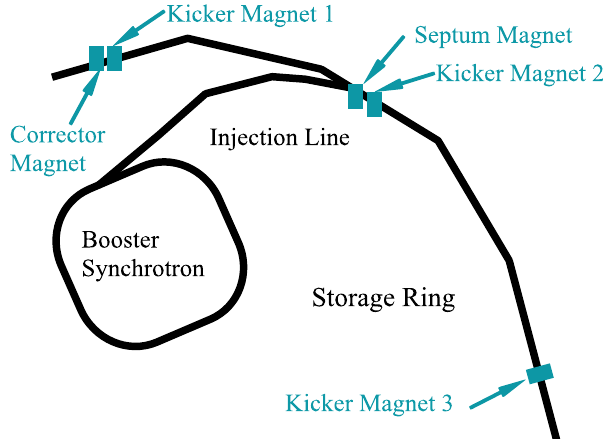
FIG. 2. In the injection scheme, electron bunches are injected from a synchrotron via an injection line into the storage ring. The relative positions of the magnets and their location are illustrated as they are placed at the storage ring KARA at KIT. See Ref. [23] for further details. The tuning parameters of the magnets and rf cavities, not shown in this figure, are used as optimization